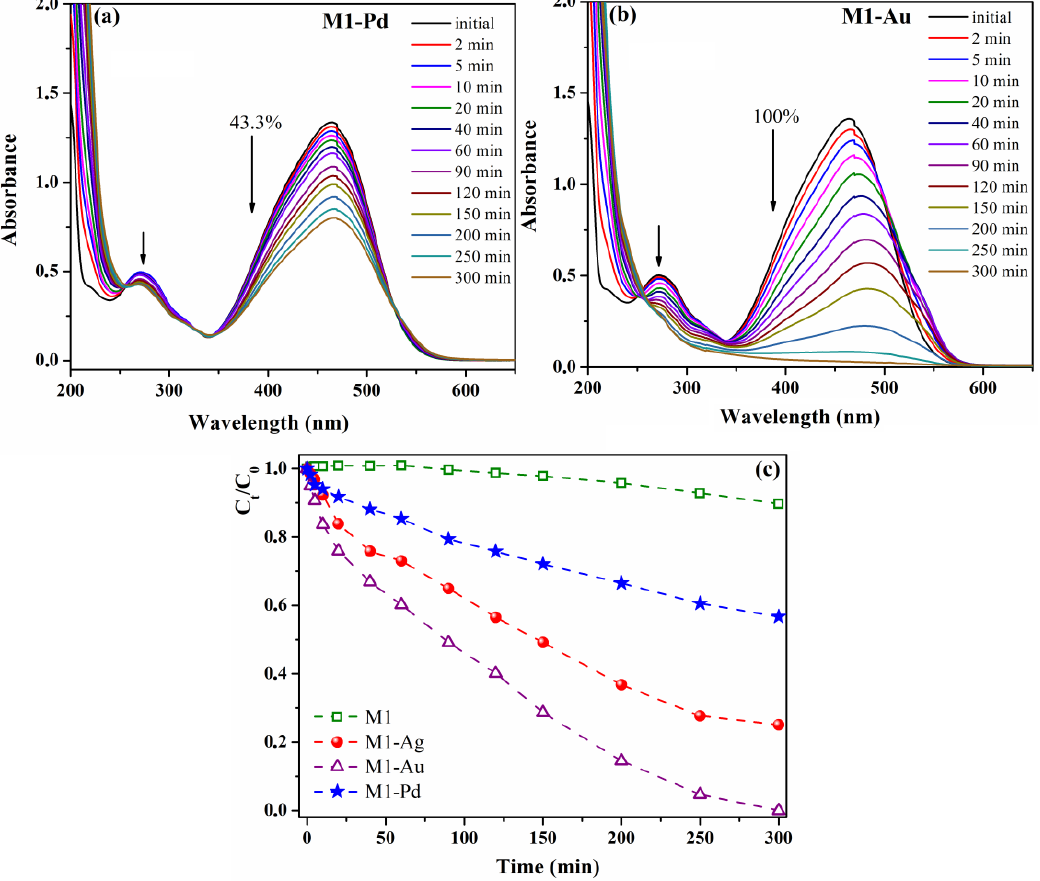
Figure 9. Modification of UV-vis absorption spectrum of methyl orange aqueous solution during visible light irradiation in the presence of M1-Pd film ( a ) or M1-Au film ( b ); temporal evolution of methyl orange photodegradation efficiencies (C t /C 0 ) in the presence of hybrid films containing modified ZnO NPs (M1, M1-Ag, M1-Au, M1-Pd) ( c ).